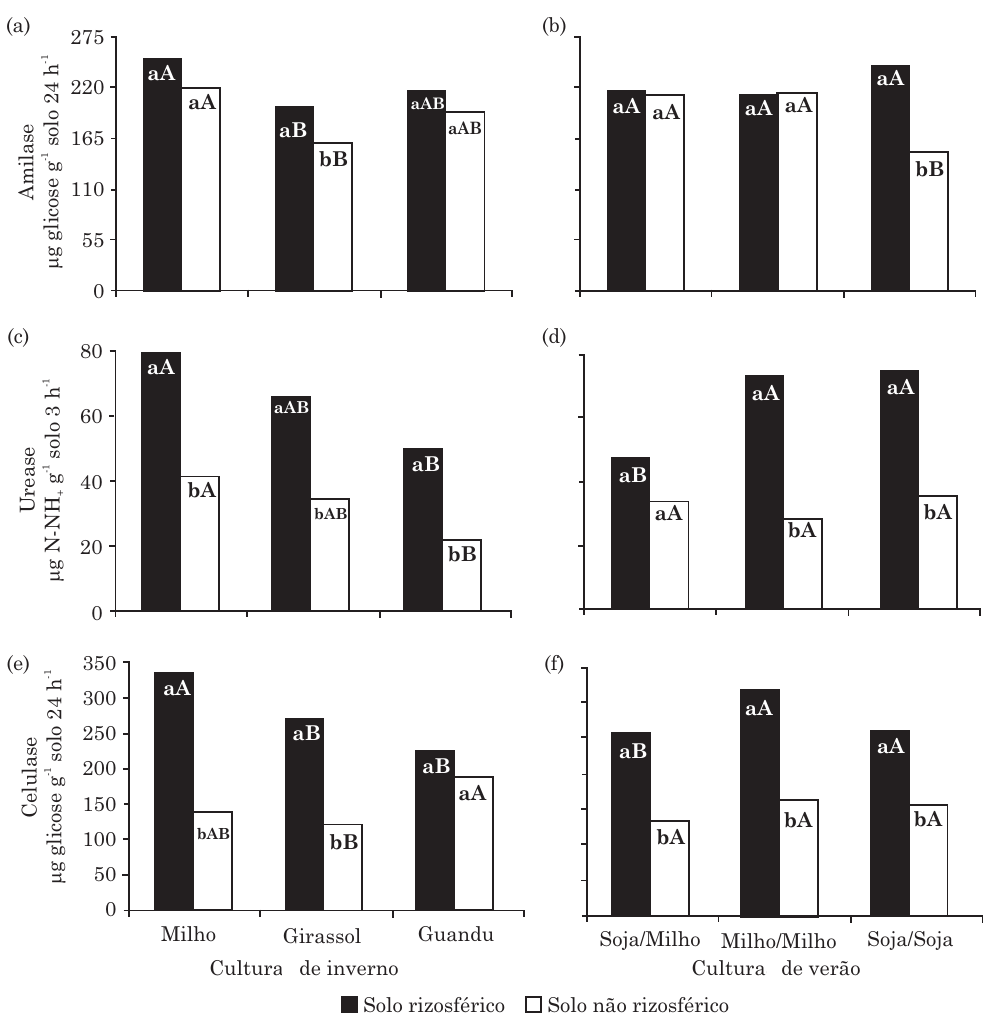
Figura 1. Efeito das culturas de inverno e das sequências de verão em sistema de semeadura direta na atividade das enzimas amilase (a, b), urease (c, d) e celulase (e, f) em solo rizosférico e não rizosférico. Letras minúsculas iguais (solo rizosférico e não rizosférico) e letras maiúsculas iguais (culturas de inverno ou as sequências de verão) não diferem entre si pelo teste de Tukey a 5